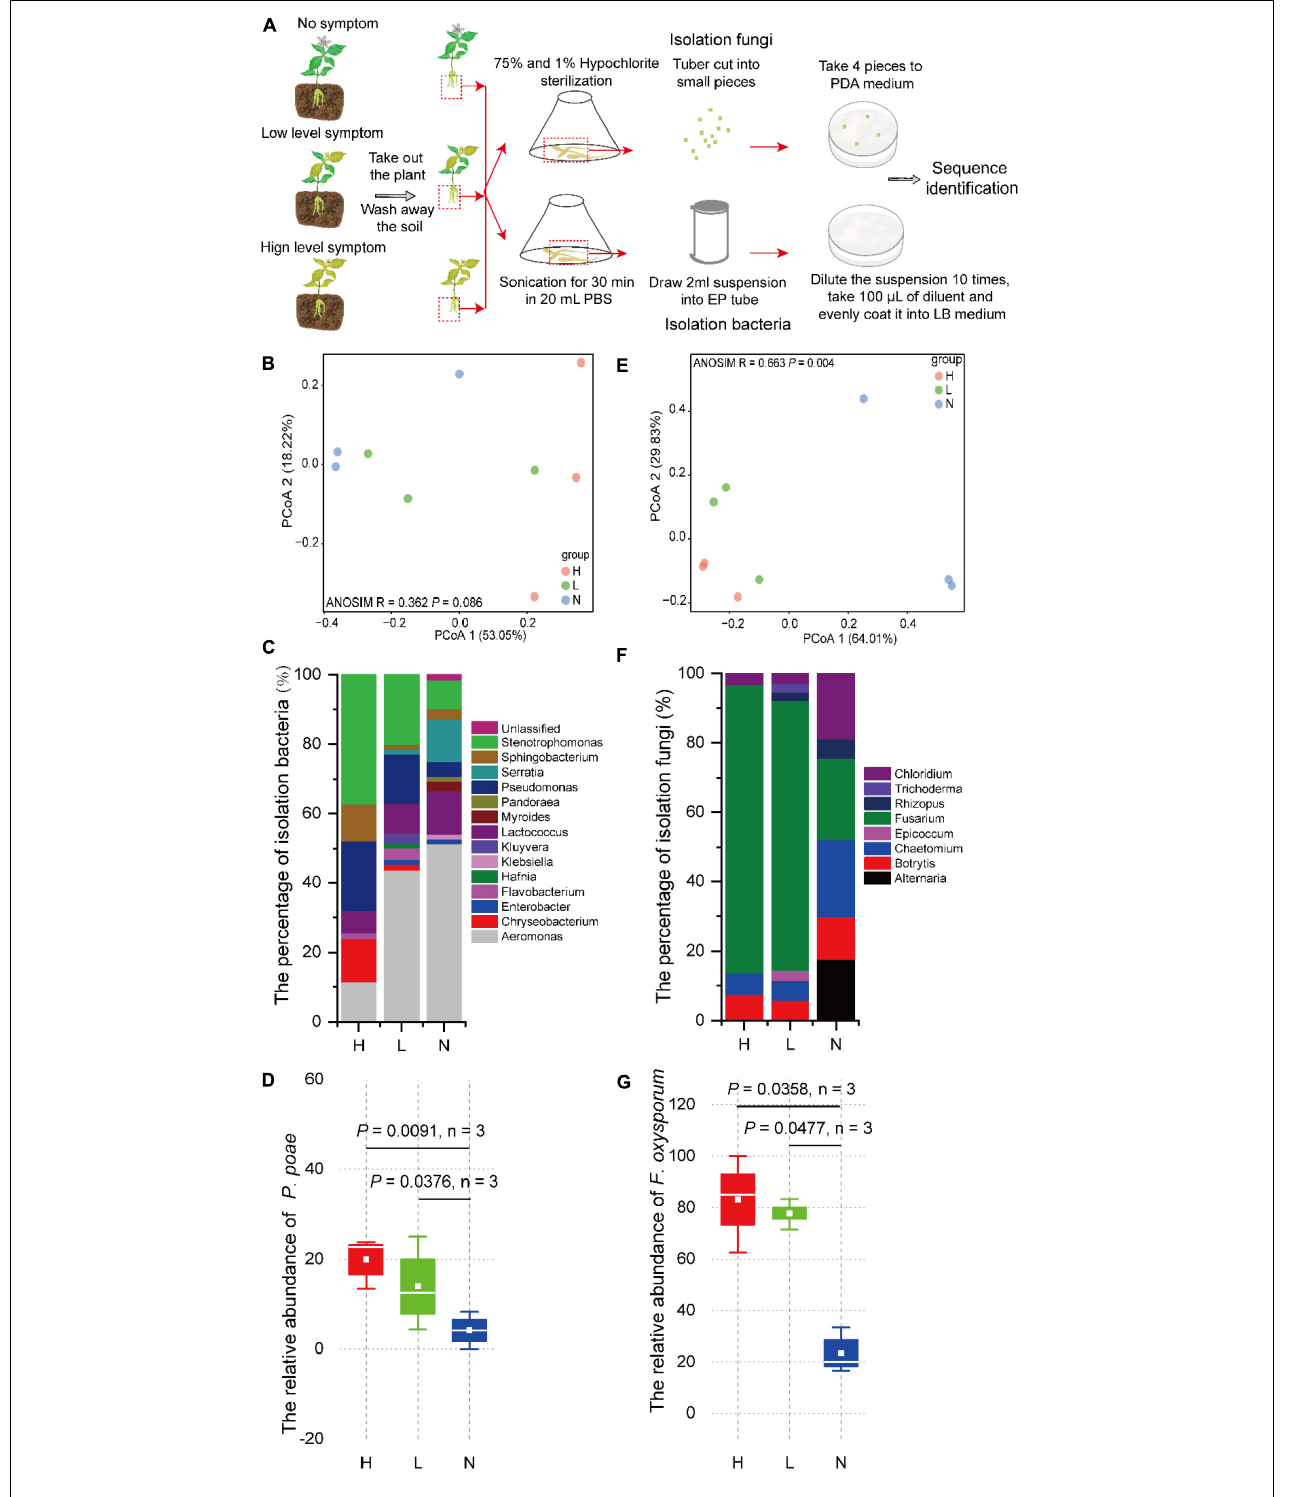
FIGURE 2 | (A) Culturable microorganisms isolated and identified from tuberous roots of P. heterophylla with different FW severity. The differences in (B) bacterial and (E) fungal community compositions among high, low, and no FW severity levels. PCoA was used to visualize the dissimilarity of bacterial and fungal compositions based on the Bray–Curtis metric at the genera level. Red, green, and blue circles denote samples in groups H, L, and N, respectively. The composition of culturable (C) bacteria and (F) fungal communities among high, low, and no FW severity levels. The relative abundance of (D) P. poae and (G) F. oxysporum was obviously and positively associated with FW severity. The two-tailed Wilcoxon test evaluated the significant differences.